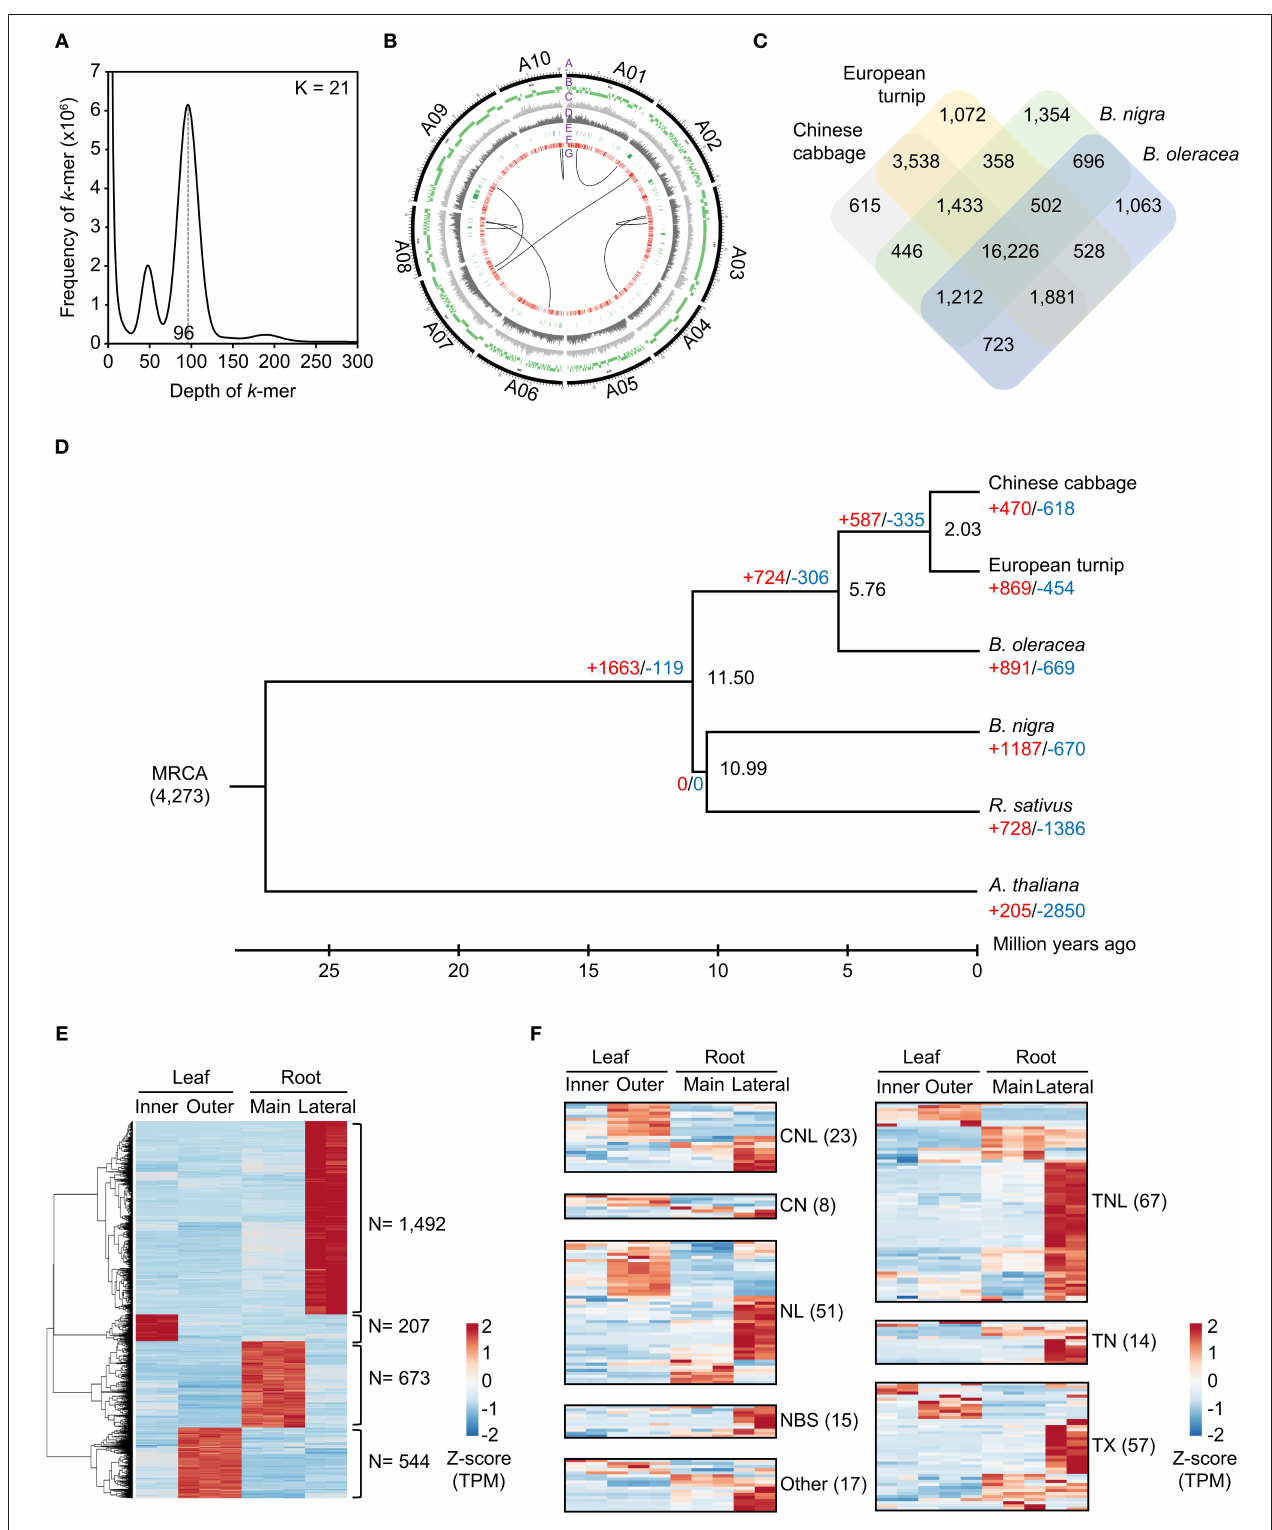
FIGURE 1 | Characterization of the draft genome assembly for the European turnip ECD4. (A) Estimation of genome size on the basis of k -mer frequency analysis. (B) Anchoring genome assembly data of European turnip to 10 chromosomes of Chinese cabbage (A1–A10). In the Circos plot, A, B, C, D, E, F, and G